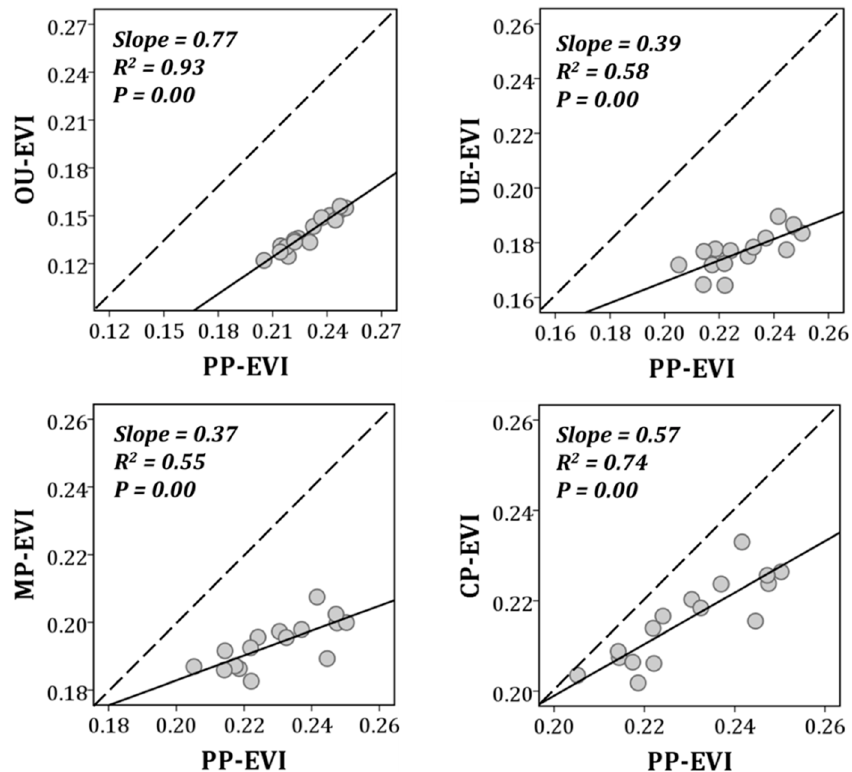
Figure 6. Relationship between pure pixels (PP) and other four land cover types for enhanced vegetation index (EVI).